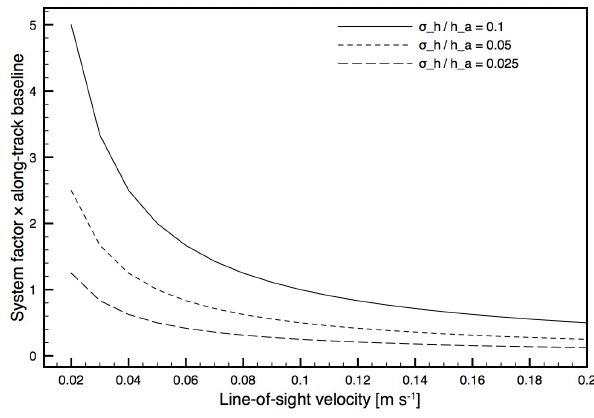
Figure 5. Along-track baseline B al multiplied with the system fac- tor C nsys versus the sea ice line-of-sight velocity for different ratios between relative height error and ambiguity height. See text for fur- ther